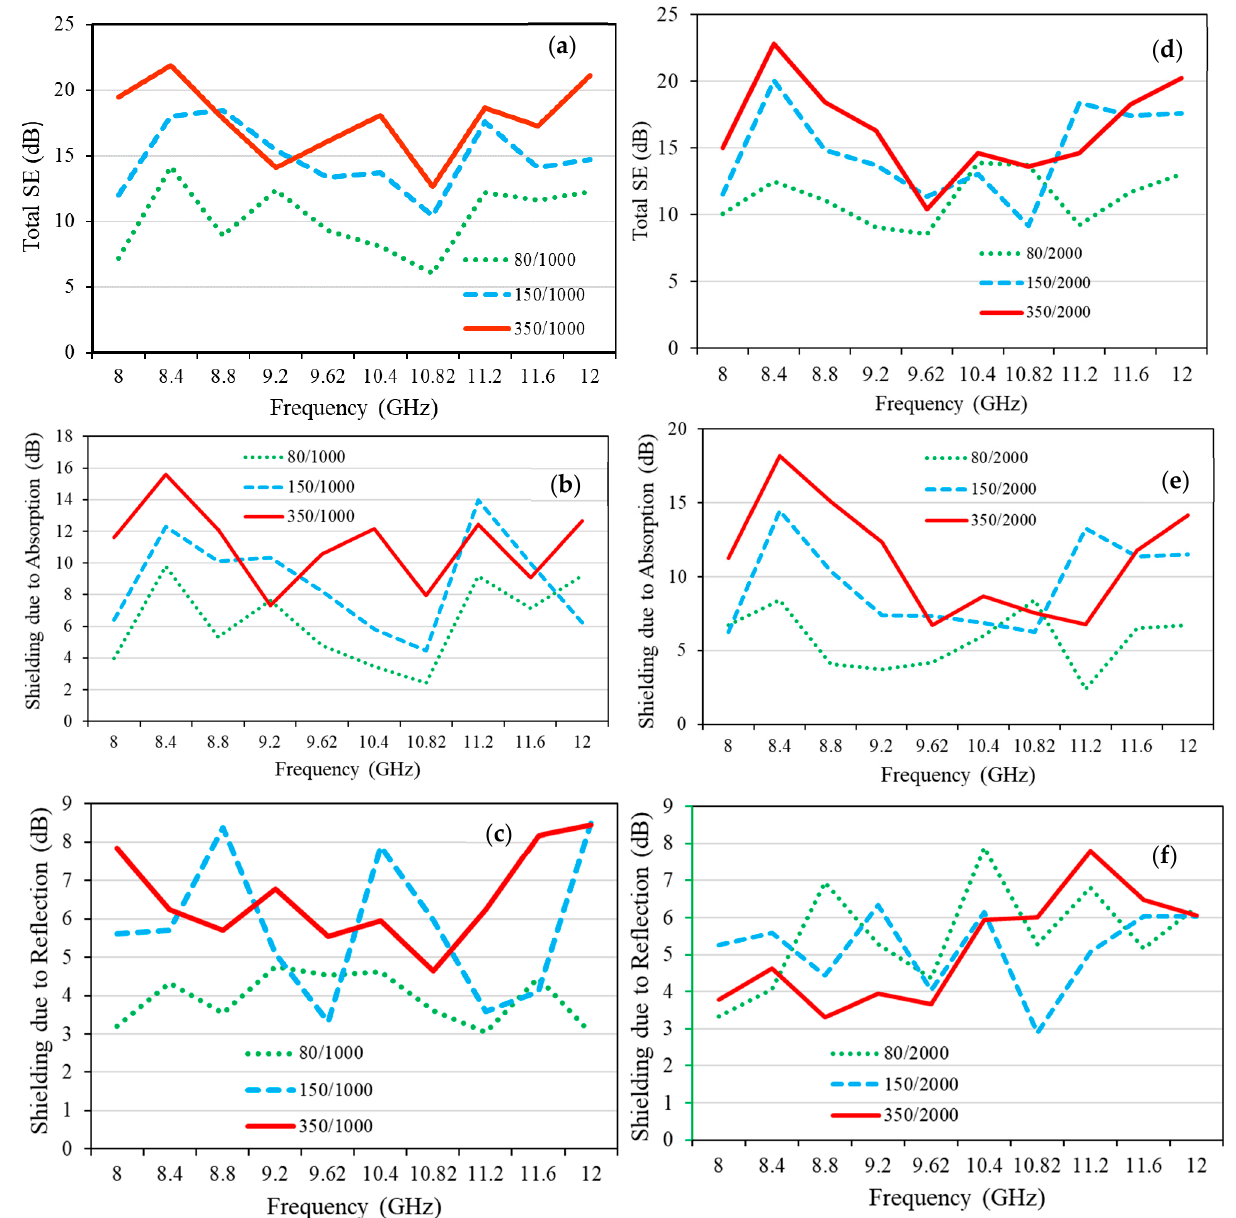
Figure 3. Shielding effectiveness of composites with no Fe 3 O 4 nano particles and carbon fibers with fiber density of 1000 fibers/mm 2 ( a ) total SE, ( b ) absorption SE, and ( c ) reflection SE; carbon fibers with fiber density of 2000 fibers/mm 2 ( d ) total SE, ( e ) absorption SE, and ( f ) reflection SE.